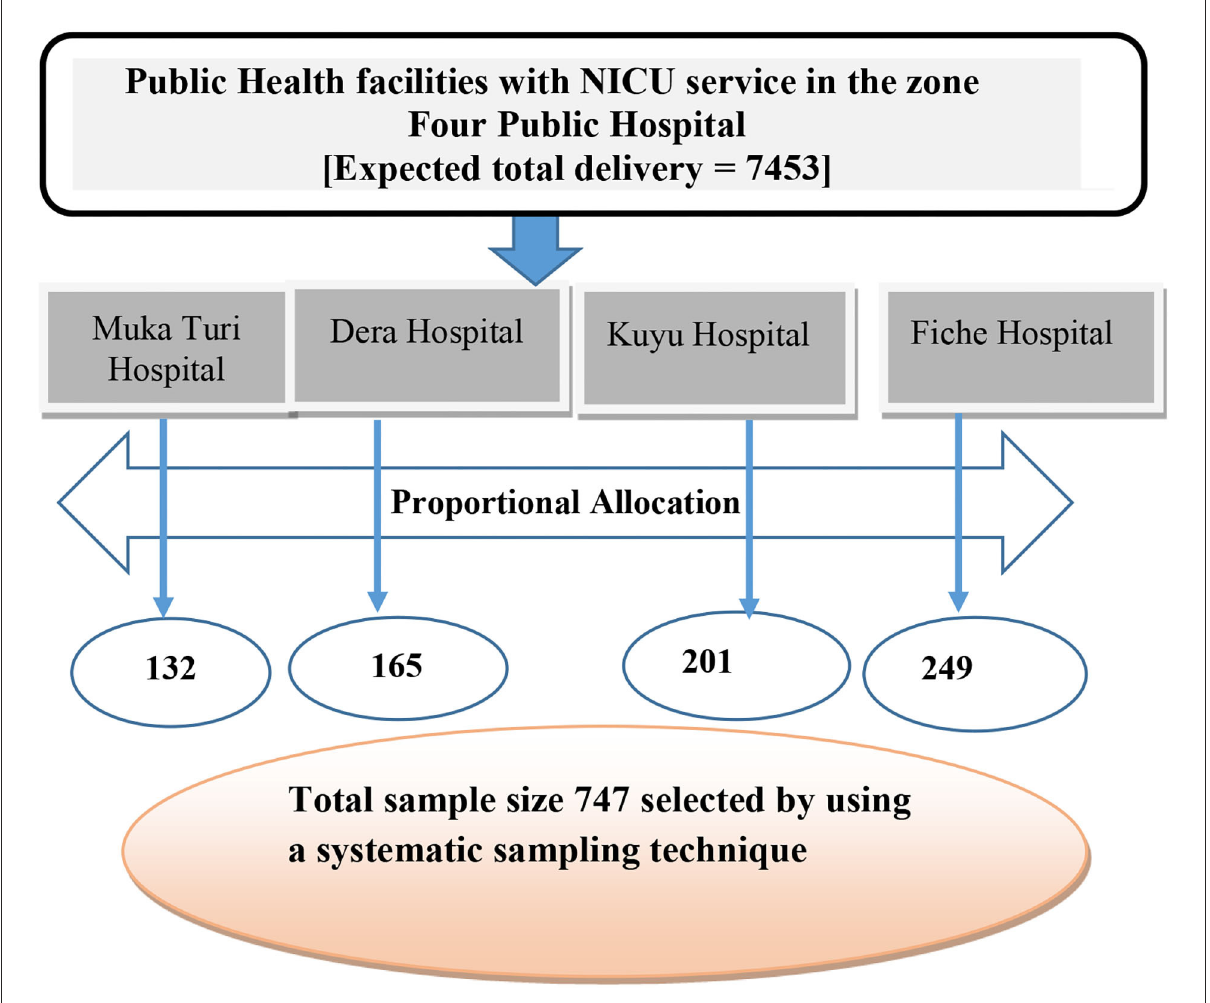
FIGURE2 Schematic presentation of sampling technique North Shewa zone public health facilities, Central Ethiopia,